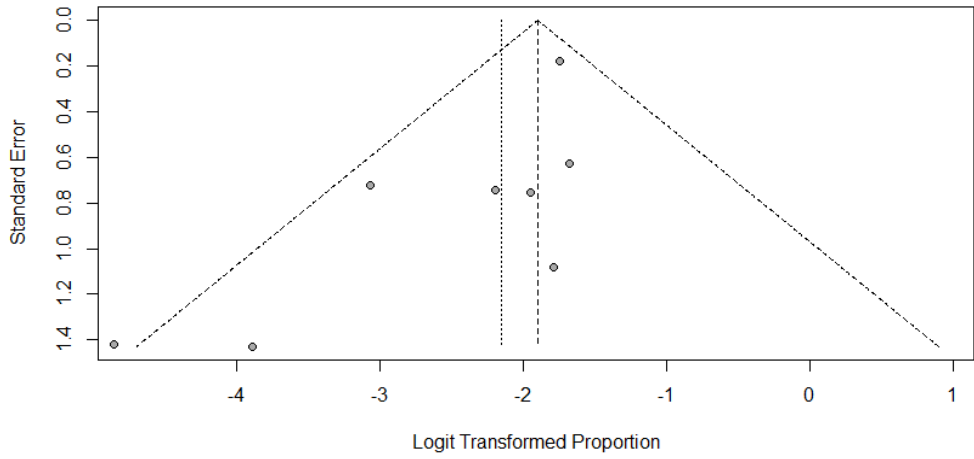
Figure 4. Funnel plots for visual appraisal of the literature bias.